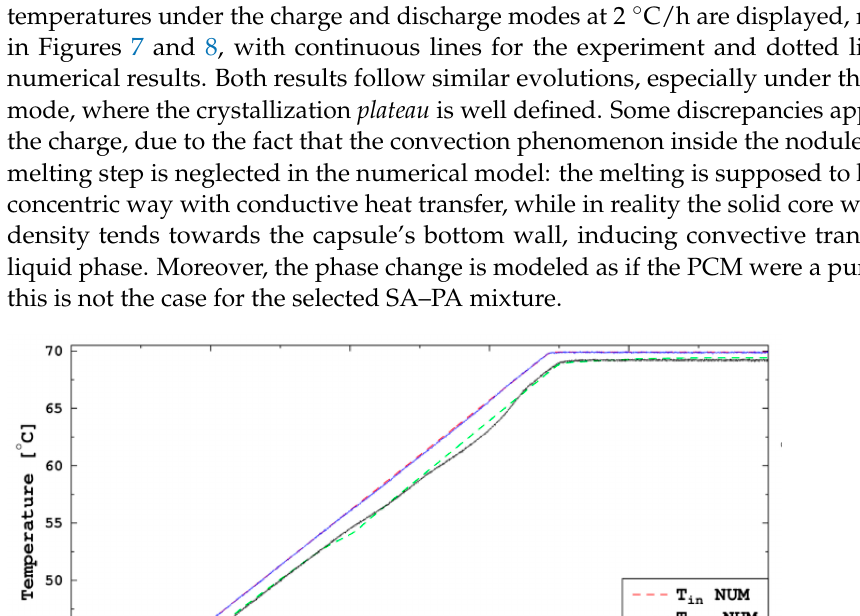
Figure 8. Discharge mode from 62.1 to 40.8 °C at 2 °C/h and 194 L/h . The global energy balance for both experiments is synthetized in Table 6 Table 6. Energy balance—model and experiment comparison. Case study: 2 °C/h, charge 43.0 - 69.9 °C at 180 L/h and discharge 62.1 - 40.8 °C at 194 L/h . Charge